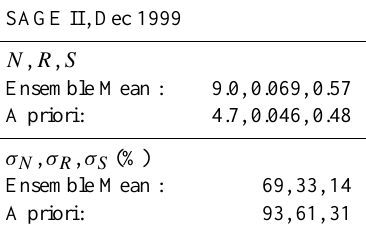
Fig. 9. Histograms of surface area density (a) , volume density (b) , effective radius (c) as derived from the retrieved size distribution parameters shown in Fig. 8. The vertical lines indicate the a priori mean. Table 5. Ensemble mean retrieved size distribution parameters (SAGE II data, December 1999) with associated uncertainties (in %). Number density is given in cm − 3 , median radius in µm, and lognormal distribution (half) width in log of µm.